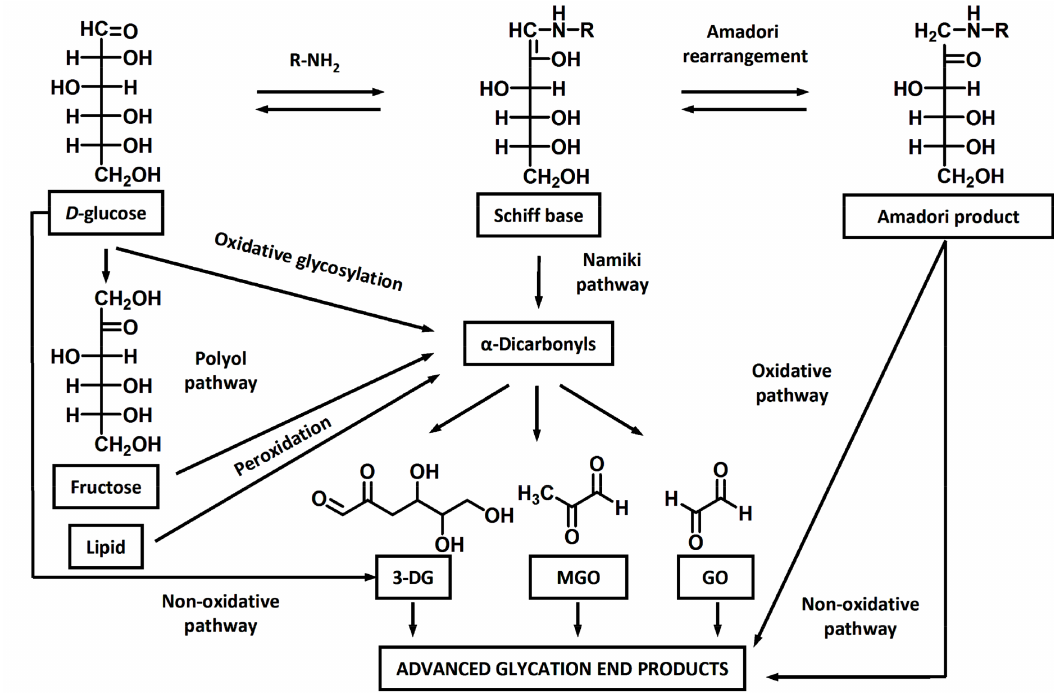
Figure 1. The major pathways of AGE formation: oxidative glycosylation [12], Namiki pathway [13], enolization [14], oxidative [15] and non-oxidative [16] degradation of early glycation products, polyol [17], and lipid peroxidation [18]. 3-DG, 3-deoxyglucasone; GO, glyoxal; MGO,